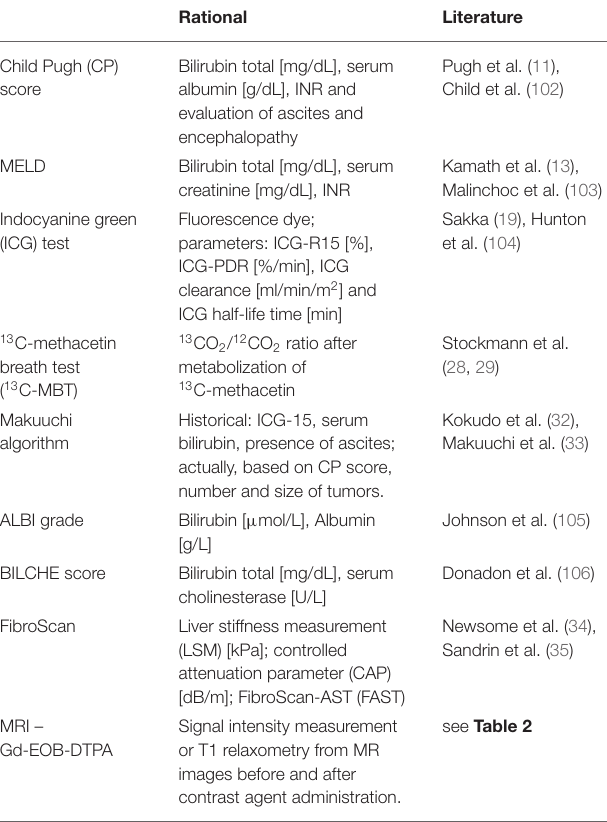
TABLE 1 | Overview of liver-related scores and